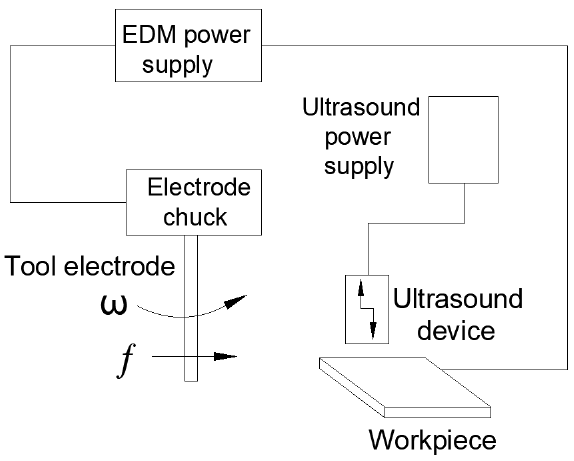
Figure 1. Diagram of EDM grinding machining.